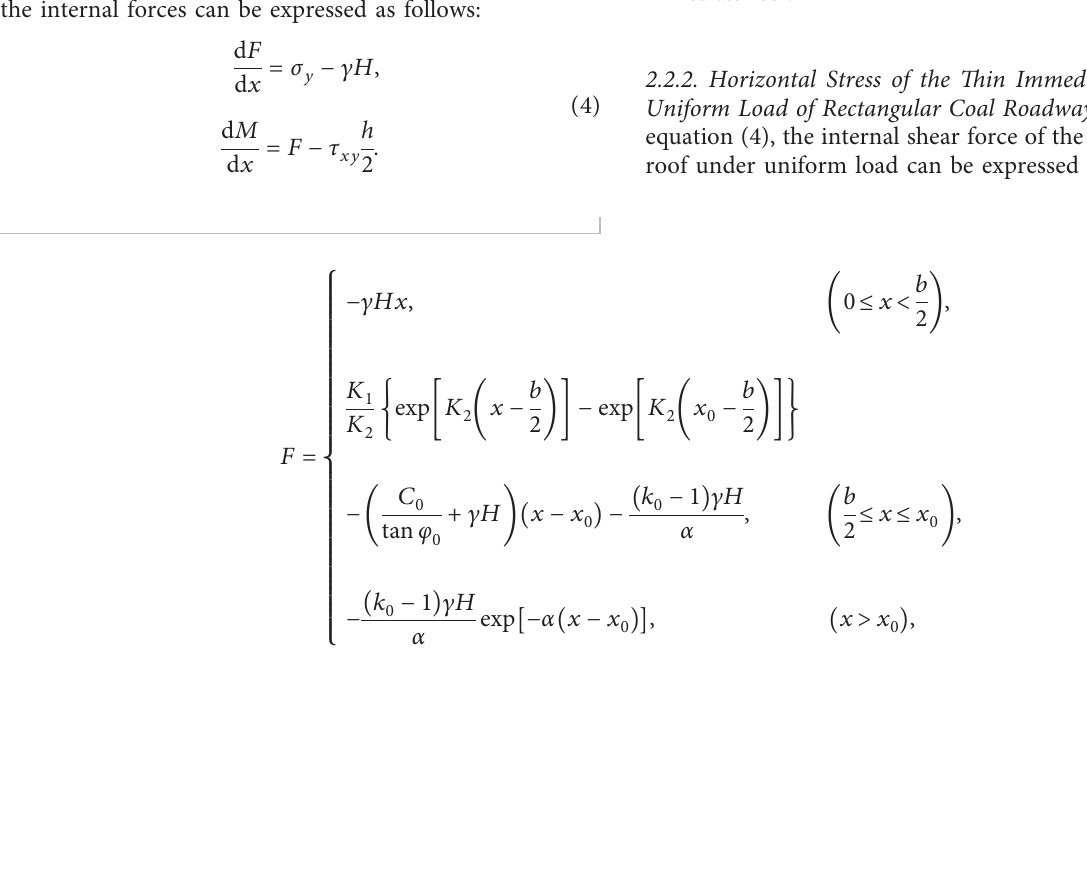
Figure 2: The model of the relationship of internal forces of thin immediate